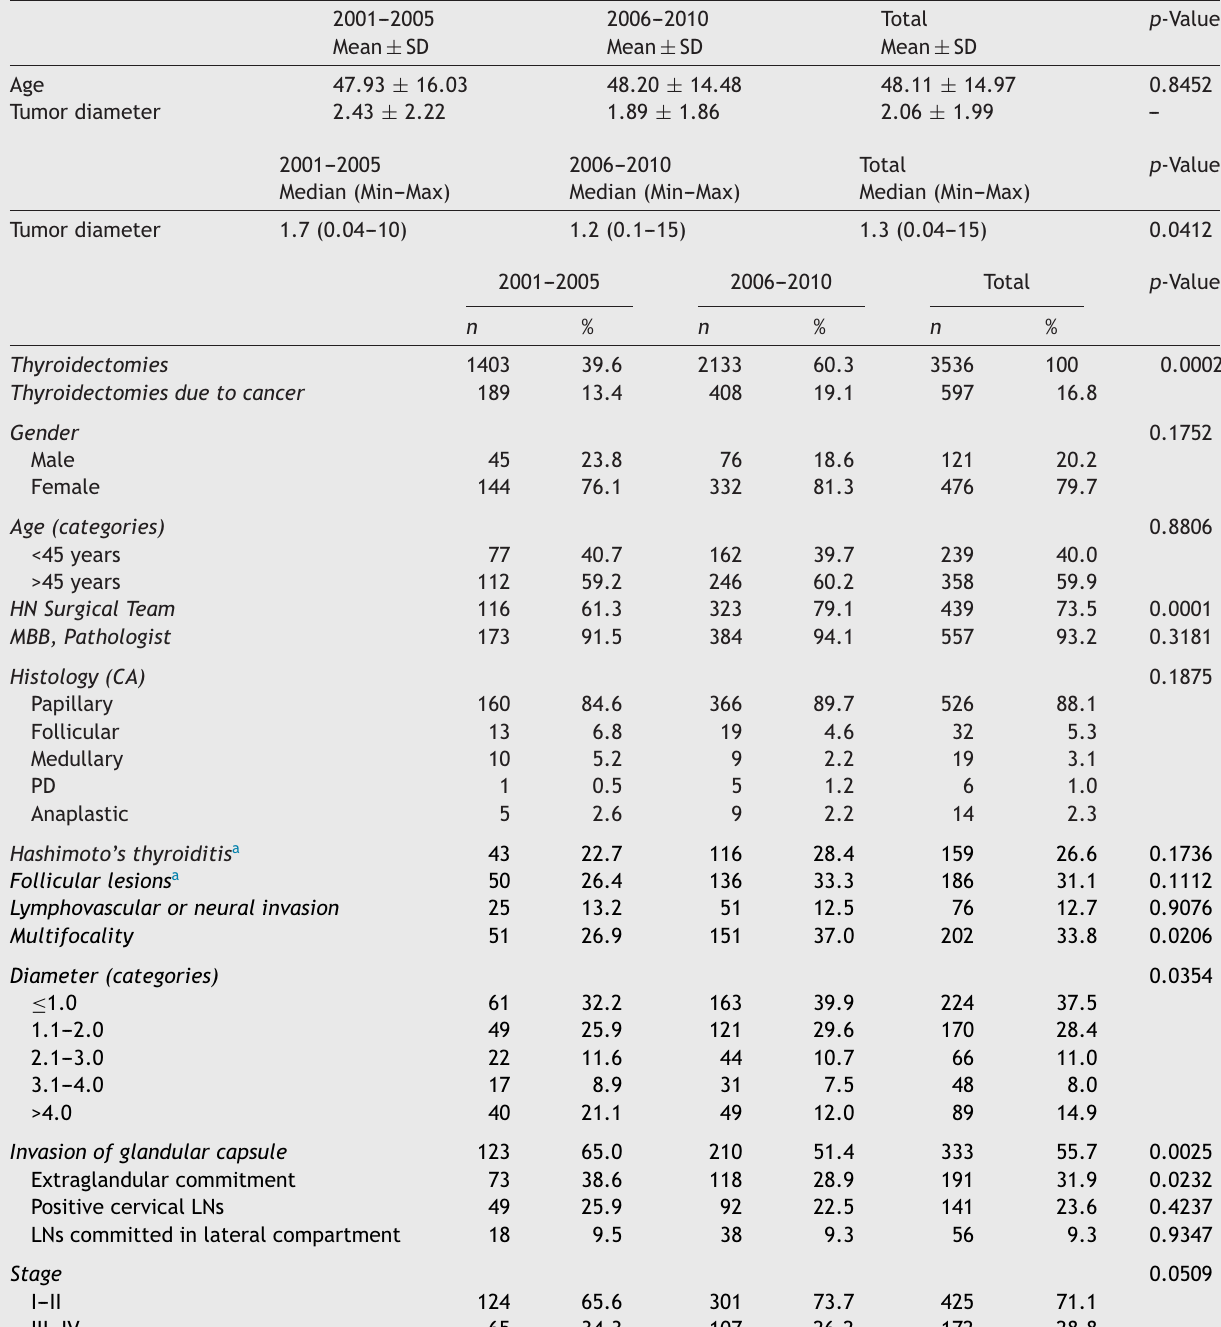
Comparative analysis of clinical and histopathological data between the two halves of the